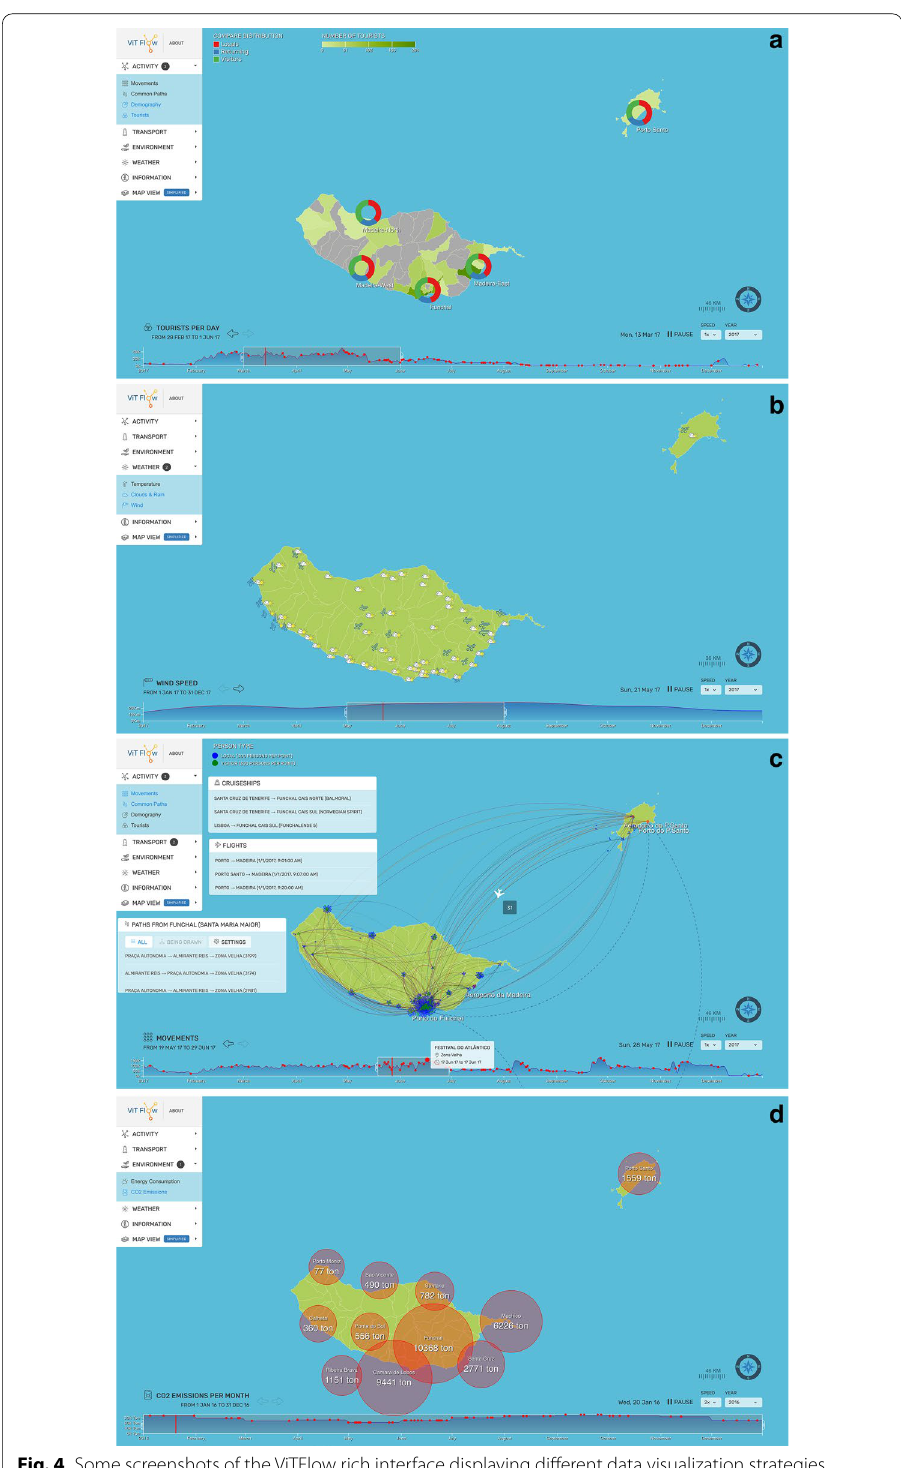
Fig. 4 Some screenshots of the ViTFlow rich interface displaying different data visualization